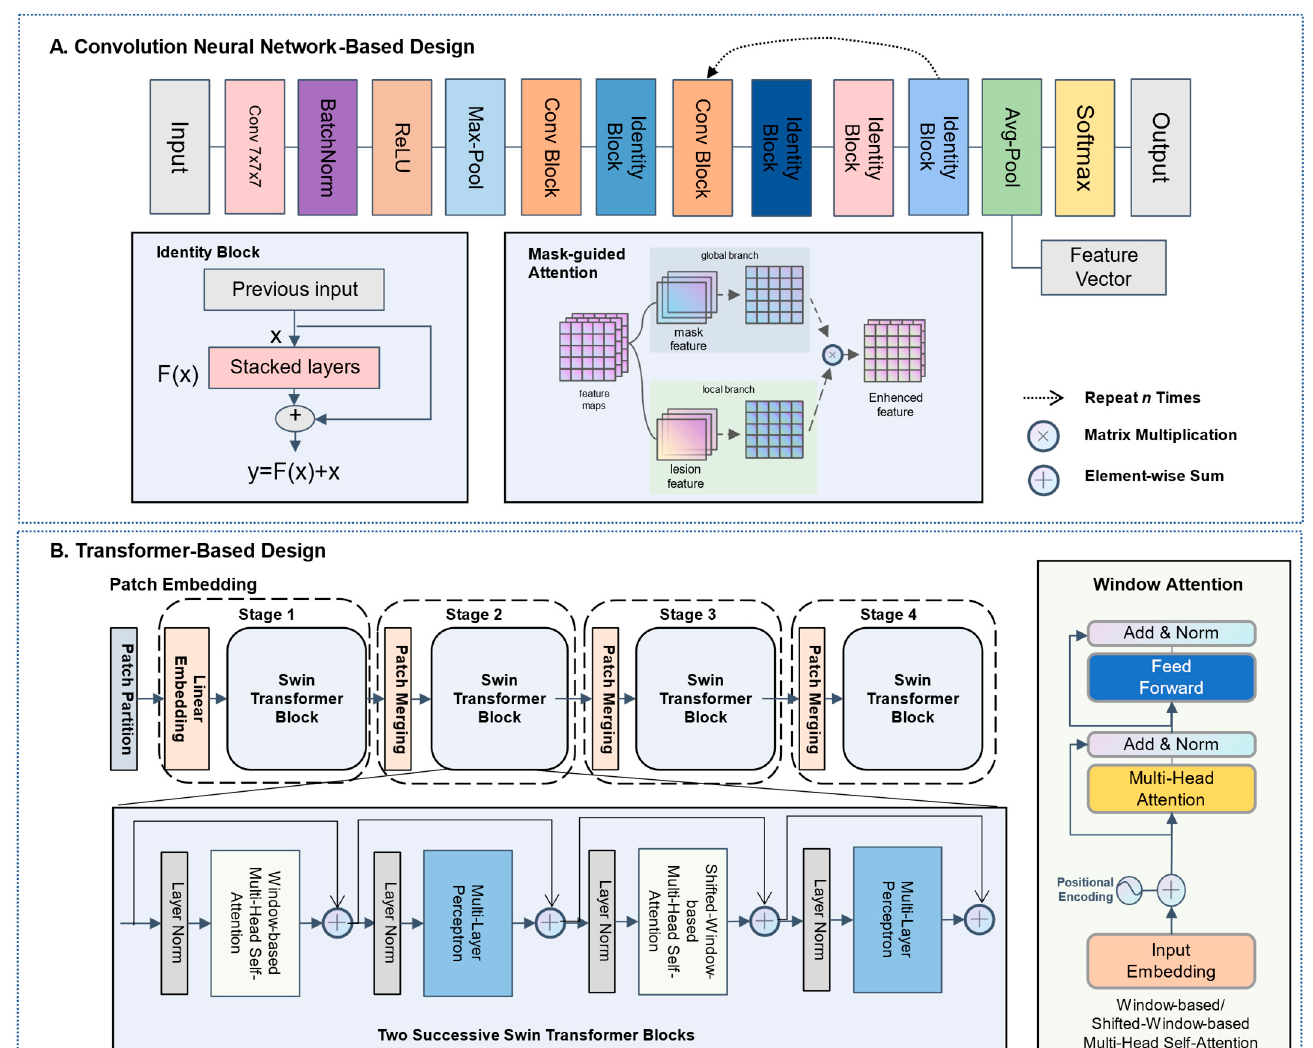
Figure 3. Overall framework of the proposed CNN-based and transformer-based network. Both proposed networks took two patches as inputs: the standardized lesion-ROI and associated mask-ROI combined two-channel volume. Before the first stage of each backbone, a mask-guide mechanism was employed to boost the model’s representation capacity. ( A ) The ResNet-3D network was developed by applying a ResNet3D-18 feature extractor to each 3D volume and employing multiple binary cross-entropy loss functions. ( B ) The Transformer network relied on the 3D-Swin-transformer as the backbone. The 3D-Swin-transformer merged image patches to build hierarchical feature maps. Two Successive Swin Transformer Blocks performed cyclic shift of local windows for shifted-window-based self-attention computation and the multi-head self-attention Module computes self-attention within each local 3D window.